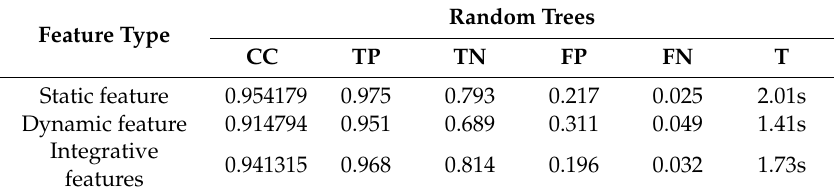
Table 7. The results of the random trees algorithm. CC (Correctly Classified rate, CC), TP (True Positive